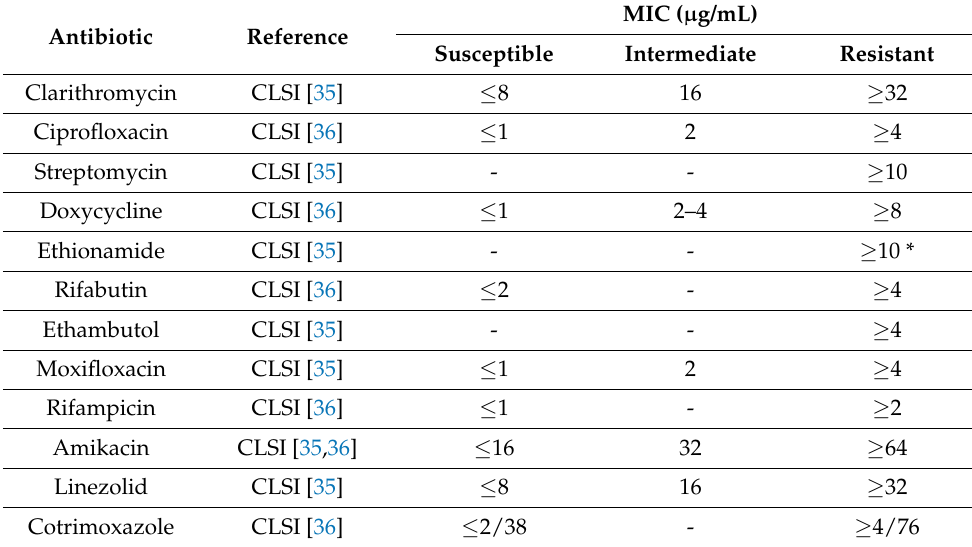
Table 3. Break point recommendations for the interpretation of antimicrobial susceptibility testing for slow-growing